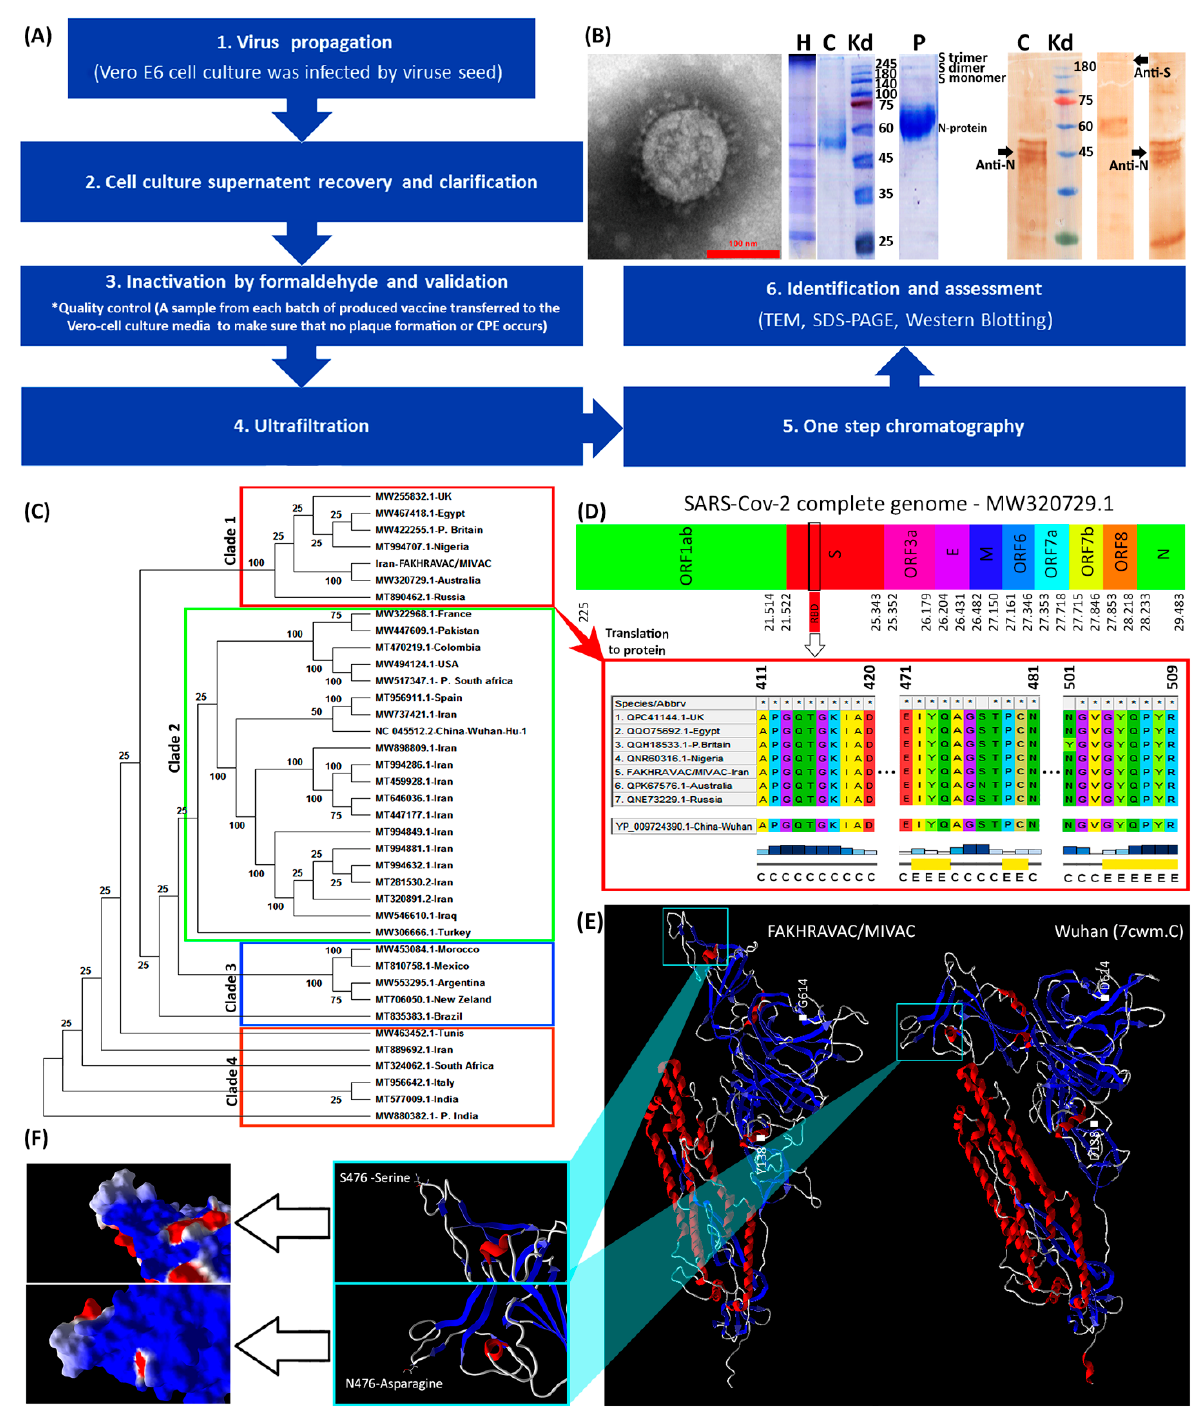
Figure 1. Characterization of viral strains. ( A ) A summary diagram of the procedures that were involved with vaccine production. ( B ) From left to right: TEM, SDS-PAGE, and western blot results. The protein composition of FAKHRAVAC was evaluated by incubating with antibodies targeting N and S protein, which are addressed in the figure by black arrows. The topics on the lanes represents: H, harvest, C, Serum of convalescent patient; and P, purified viral solution. ( C ) Phylogenetic construct made out of the complete sequence of the SARS-CoV-2 m-RNA . ( D ) Infographic view of the coding regions of the SARS-CoV-2 virus with emphasis on multiple-alignment of their RBD regions. The letters “C” and “E” under the multiple-alignment represents secondary structure elements of “Random-Coil” and “Beta sheet” elements, respectively. ( E ) Tertiary structure of the FAKHRAVAC and Wuhan S-proteins, with a zoomed-in image on the RBD region. ( F ) Electrostatic surface of the S-protein’s RBD structure. The red, white, and blue represent negative, neutral, and positive charge, respectively.